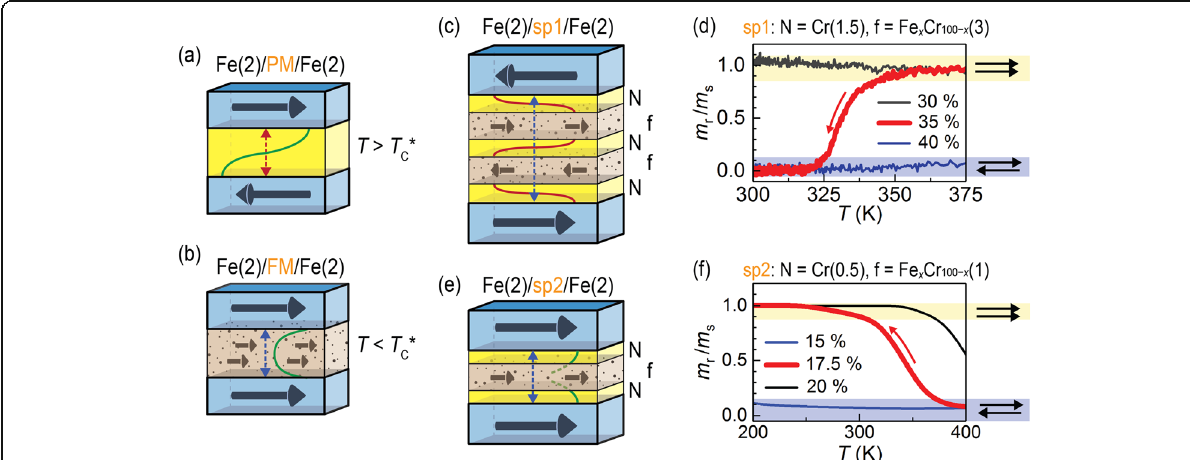
Fig. 1 Illustration of magnetic layout of Fe/uniform-spacer/Fe multilayers when the spacer is paramagnetic (PM) ( a ) or ferromagnetic (FM) ( b ). c , e Structures with modified, composite spacers sp1 and sp2 exhibit, respectively, antiparallel and parallel magnetic ground state at low temperature ( T < T C* ). d , f Corresponding characteristic temperature variation of remanent magnetization of structures with spacers sp1 and sp2 for different compositions of spacers ’ inner diluted alloy layer. Layer thicknesses are given in parentheses in “ nanometers ”